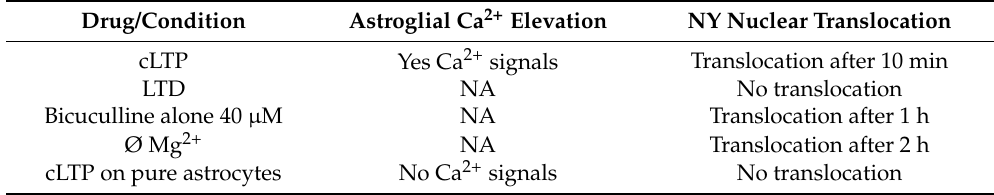
Table 1. Stimuli which induced nuclear NY translocation in